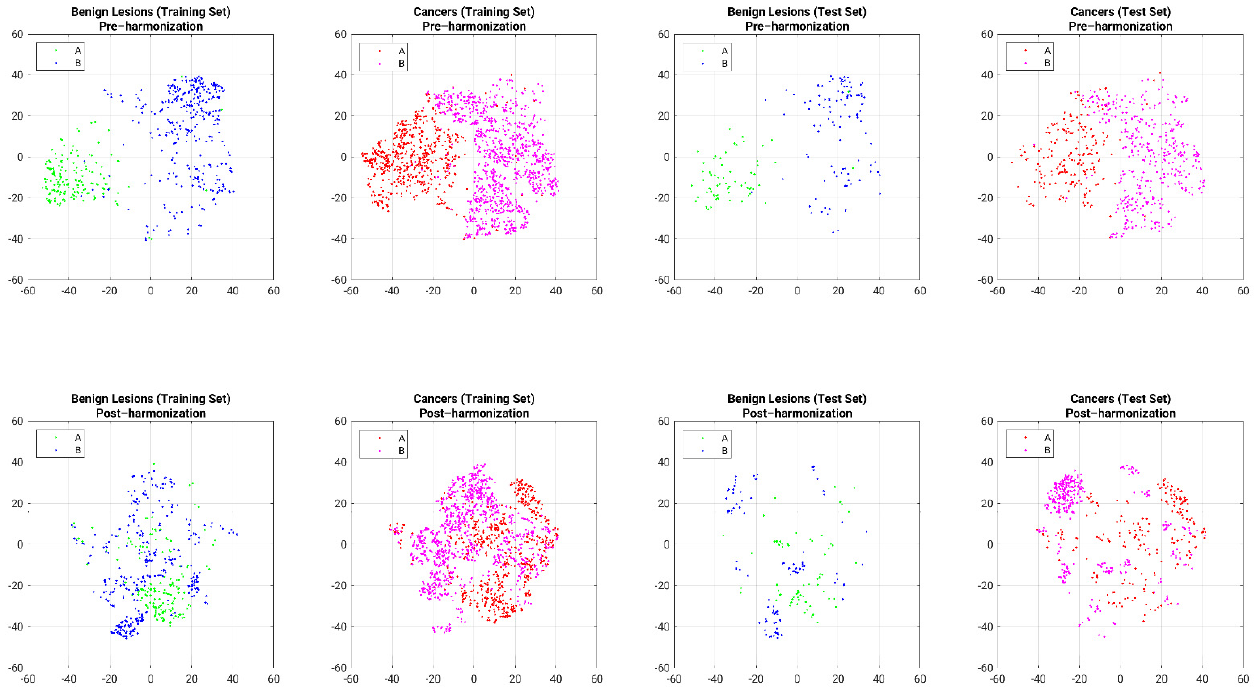
Figure 5. Feature value harmonization visualized through t-SNE presentations of pre-harmonization (top row) and post- harmonization (bottom row) by lesion type (benign lesion or cancer) and feature set (training or test set). Harmonization was conducted on the combination of benign lesions and cancers in the training set without covariate of lesion type and applied to lesions in the test set without covariate of lesion type. Results shown here are separated out by lesion type (cancer or benign) to aid in visualization only (A: Database A; B: Database B).